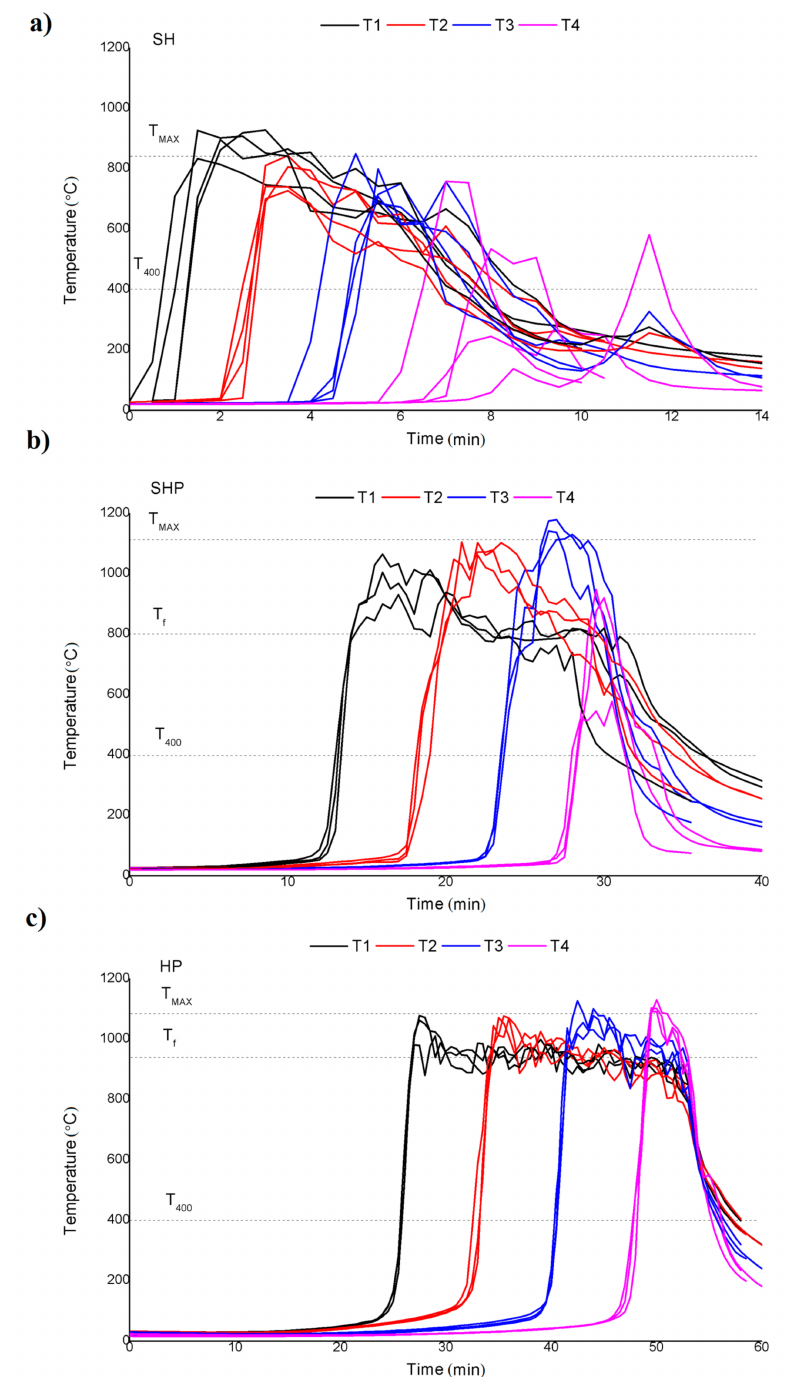
Figure 2. Temperature characteristics for combustion of ( a ) sunflower husk, ( b ) sunflower husk pellets, and ( c ) hardwood